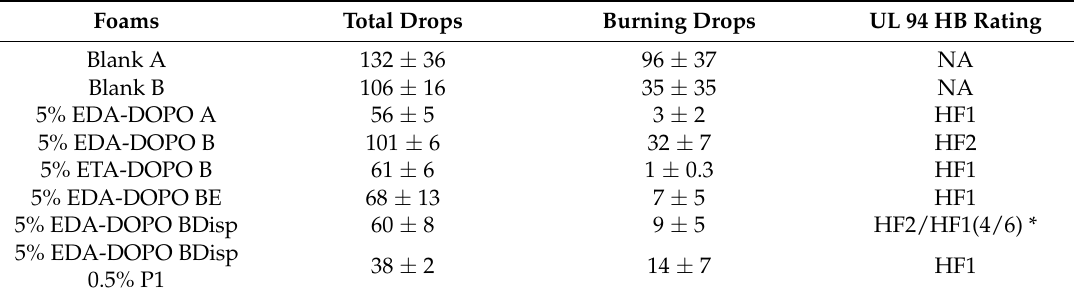
Table 6. Dripping behavior analysis of PU